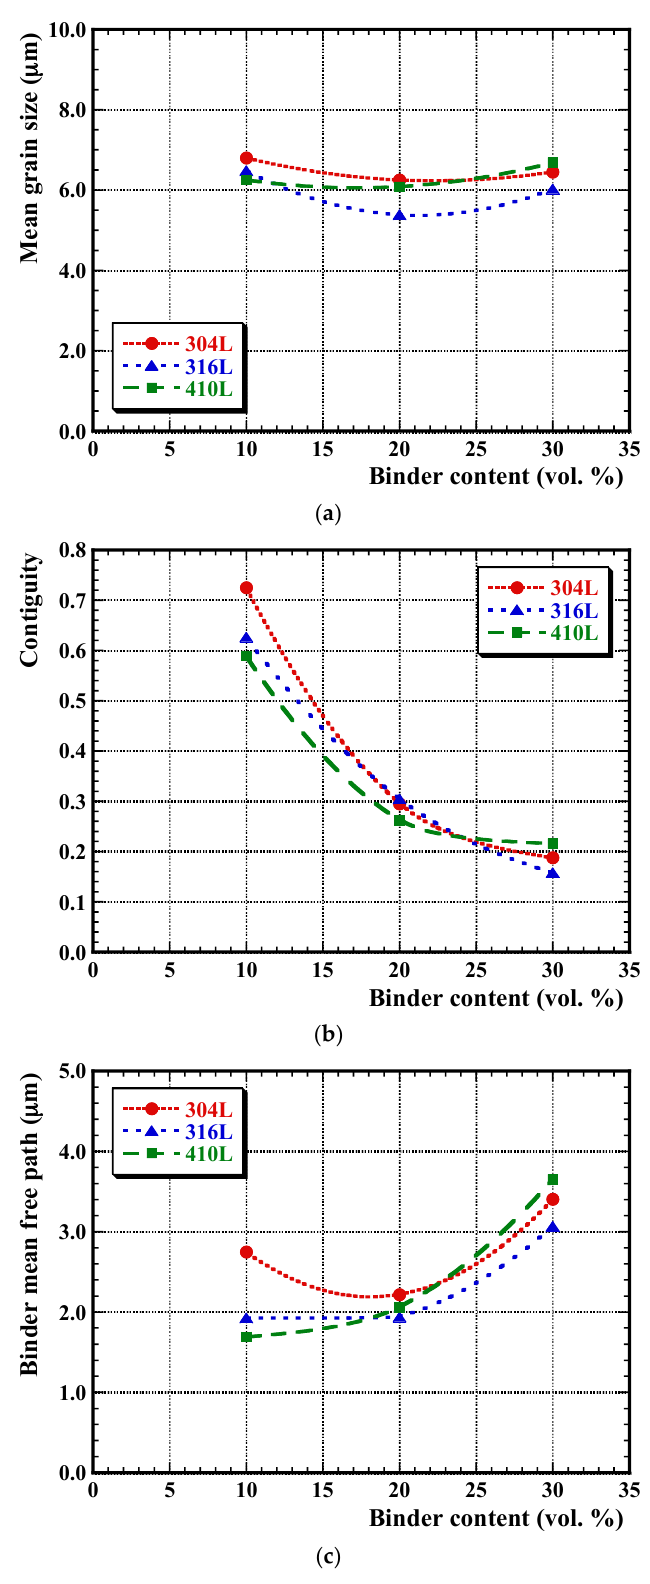
Figure 2. The effects of binder composition and content on ( a ) grain size; ( b ) contiguity; and ( c ) the binder mean free path assessed for the TiC–stainless steel cermets.